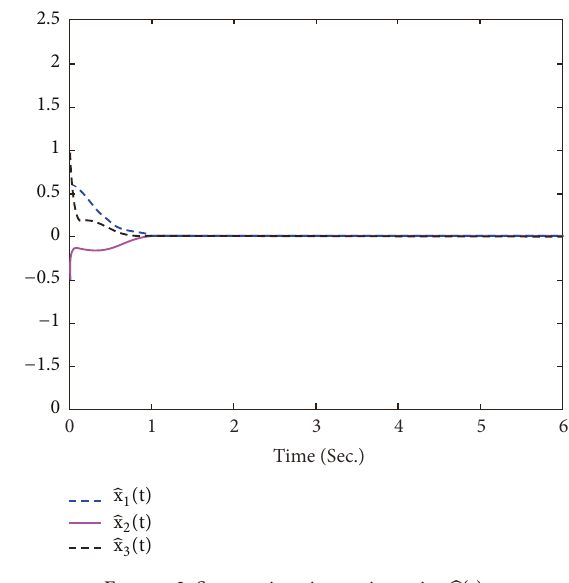
Figure 3: State estimation trajectories ̂𝑥(𝑡) .